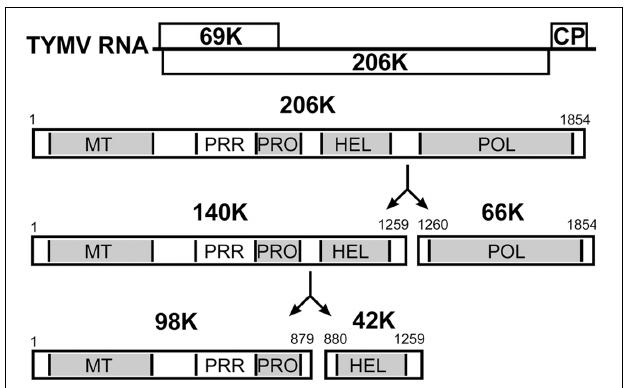
FIGURE 1 | Schematic representation of the genomic organization of TYMV RNA and 206K protein processing. The open reading frames are indicated by open rectangles, and correspond to the 69K suppressor of RNA silencing and movement protein, the 206K replication polyprotein and the coat protein (CP). Protein functional domains of the encoded 206K protein are indicated. 206K is proteolytically processed at peptide bonds 1259–1260 (HEL ↓ POL) to generate 140K and 66K. The former is further processed at peptide bonds 879–880 (PRO ↓ HEL) to generate 98K and 42K (Jakubiec et al.,